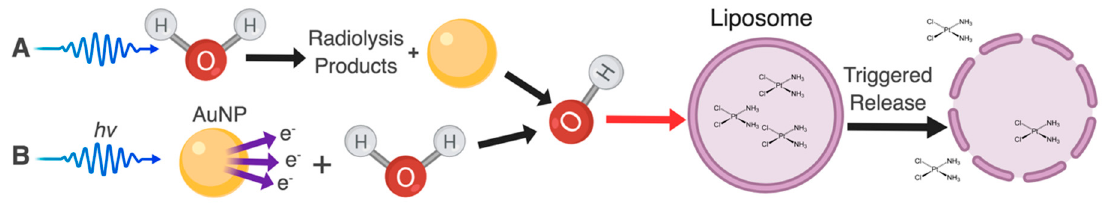
Figure 4. Schematic of the mechanisms associated with RT that can be used to destabilize liposomes. The mechanisms are as follows: ( A ) The interaction of radiation with water to produce radiolysis products that can interact with AuNPs to amplify hydroxy radical production. These radicals can then destabilize liposome bilayers for triggered drug release; ( B ) The interaction of radiation with AuNPs to produce secondary electrons (such as Compton scattering and Auger electrons) which can then interact with water to produce hydroxy radicals. These radicals can then destabilize liposome bilayers for triggered drug release.